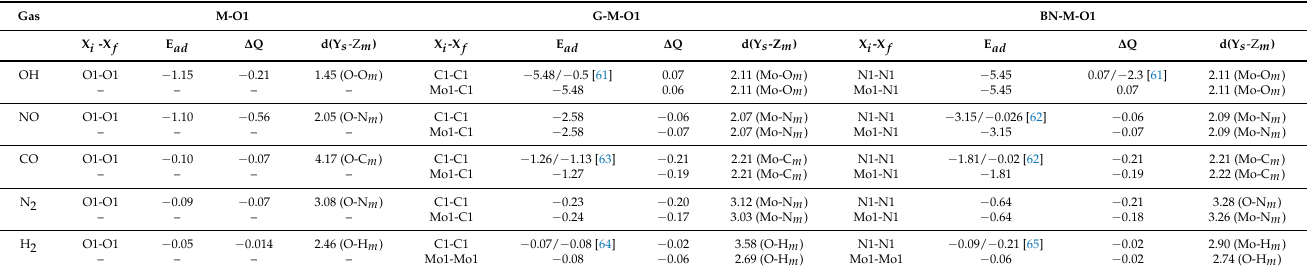
Table 2. (X i -X f ) refers to the adsorbed site (before-after) relaxation, E ad is the adsorption energy (eV), the closest distance between the sheet and molecule is d(Y s -Z m ) (Å), where Y s and Z m indicate the sheet atom and adsorbed-molecule atom, respectively. ∆ Q (e) is the charge transfer, which is negative when a charge is transferred from the structure to a molecule. The references in the adsorption energy columns refer to the corresponding values of the gas adsorption on G, and h -BN monolayers. G-M-O1 BN-M-O1